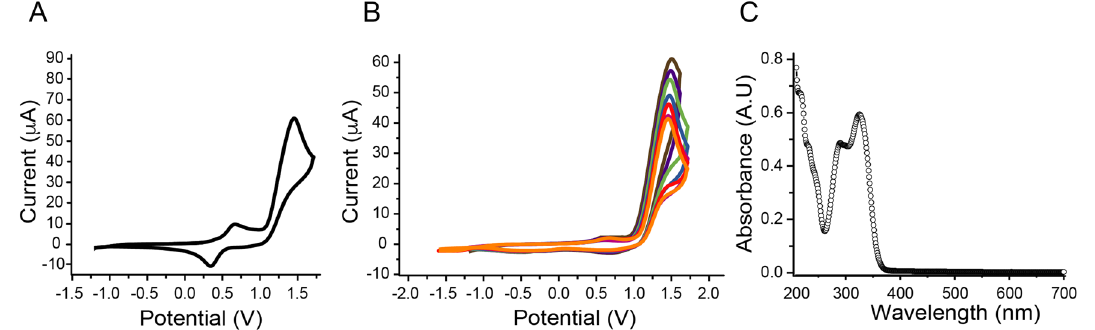
Figure 4. Electrochemical behavior of RA by cyclic voltammetry. ( A ) Cyclic voltammogram of RA in presence of 0.1 M Bu 4 NPF 6 solution in CH 3 CN compared with internal standard ferrocene. ( B ) Cyclic voltammetry experiments recorded between − 1.5 and 1.6 V with sweep rate of 100 mV/s with a platinum working electrode. ( C ) UV–Visible spectrum of RA in CH 3